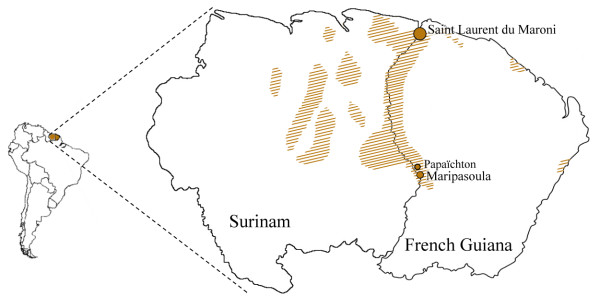
Geographic location of the Noir Marron communities sampled. The brown hatched areas locate the Noir Marron communities in Surinam and in French Guiana. The brown points represent the communities sampled and their relative size depends to the number of sampled individuals.